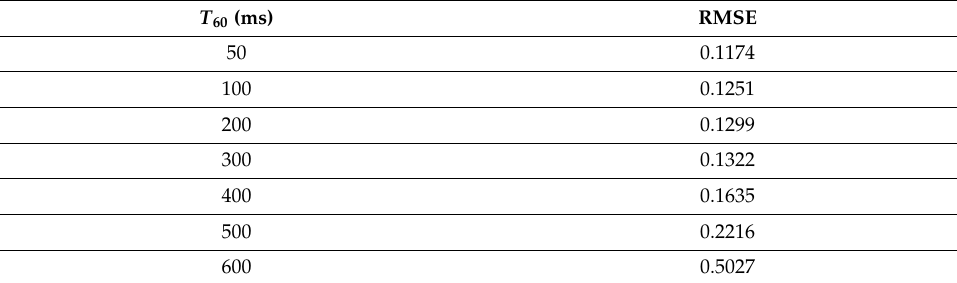
Table 4. RMSE versus T 60 with SNR = 20